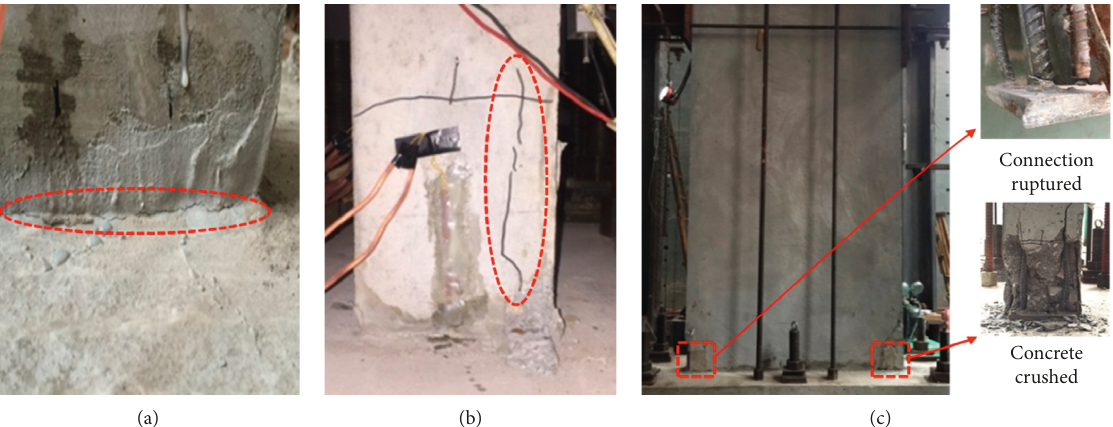
Figure 14: Observed damages of the specimen during the test: (a) tension crack of the filled interface, (b) compressive crack of the concrete, and (c) the failure mode.